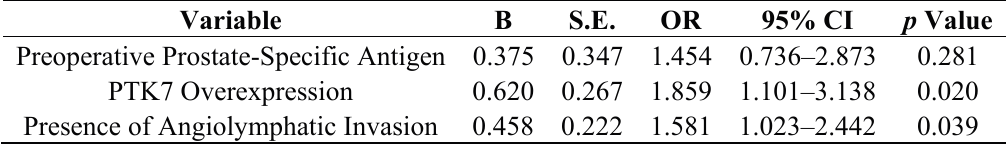
Table 3. Factors predictive of lymph node metastasis in the multivariable analysis.